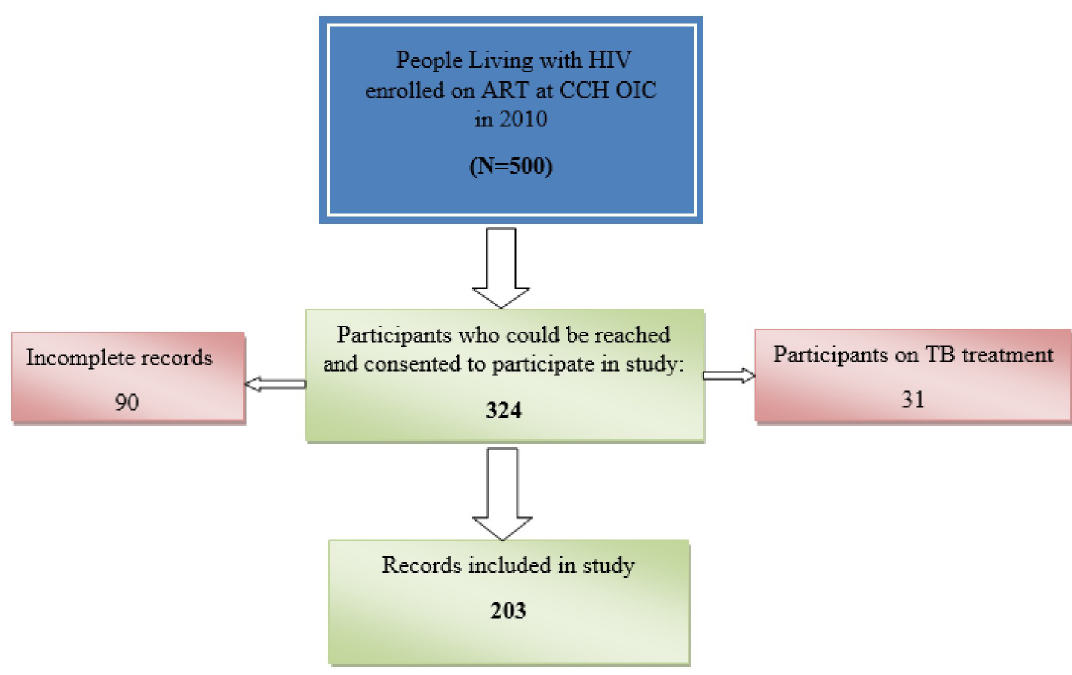
Fig 1. Participants’ records selection flow